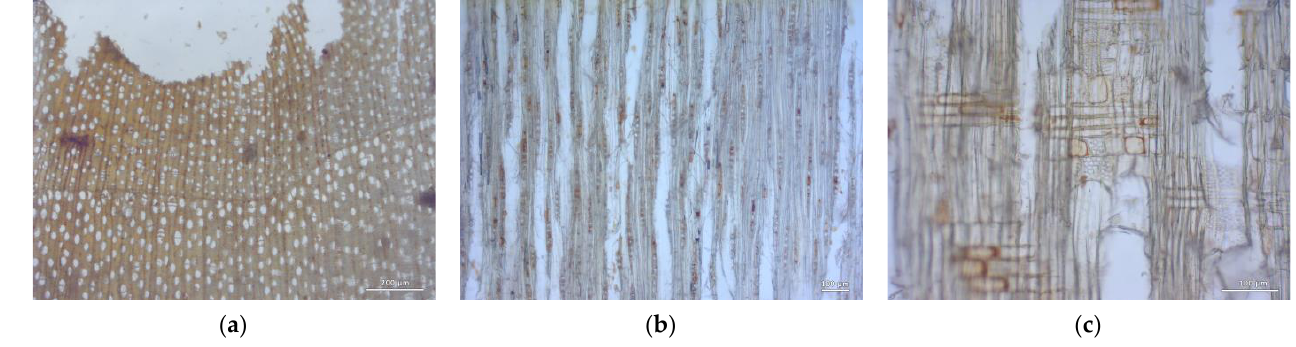
Figure 12. Characteristic sections identified as belonging to the Salix genus: ( a ) Transversal section of sample LU1b; ( b ) Longitudinal section of sample LU1b; ( c ) Radial section of sample LU1b.